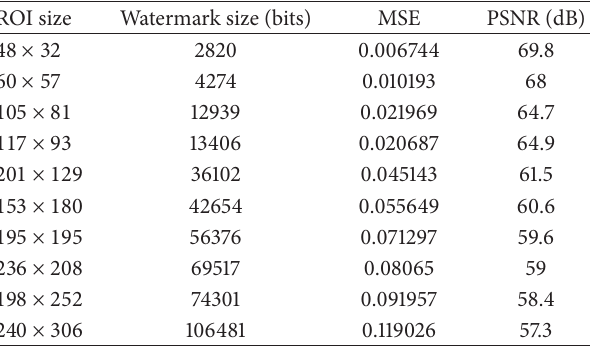
Table 5: Embedding performance of XA scan image of size 1024 × 1024